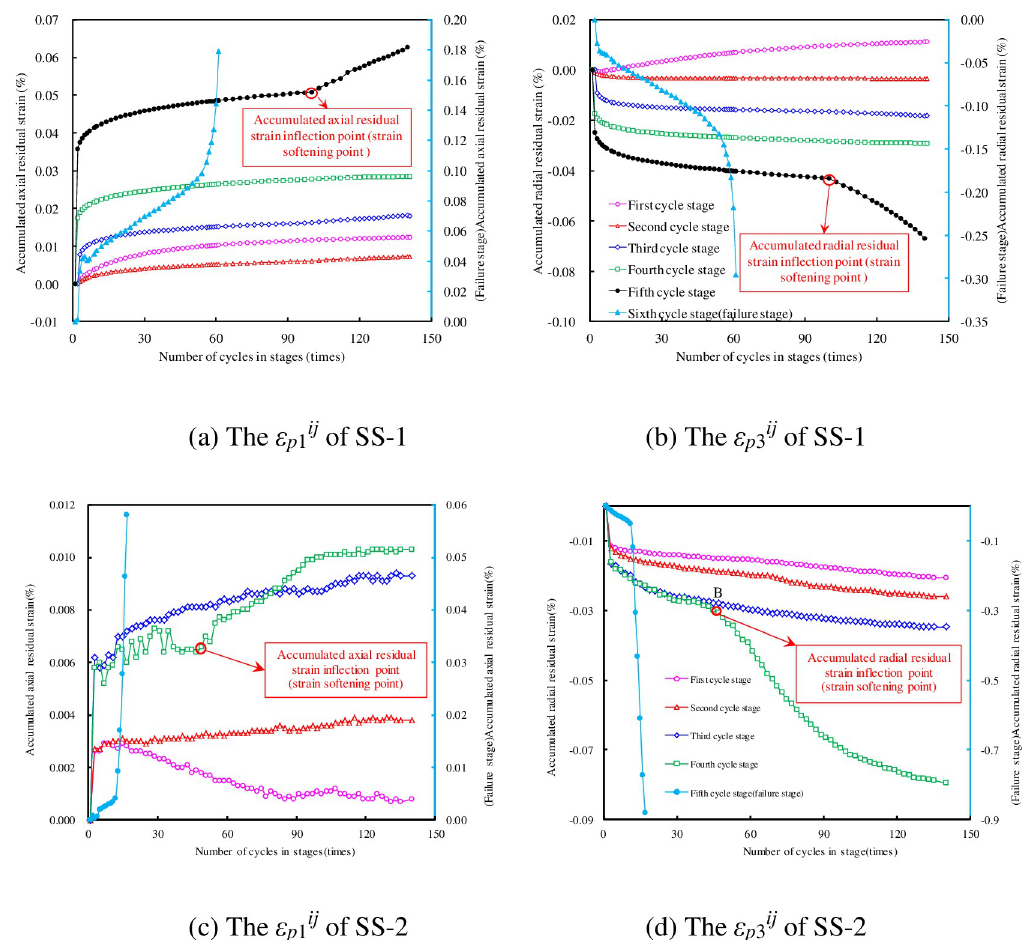
Fig 7. Accumulated residual strain curves at different cycle